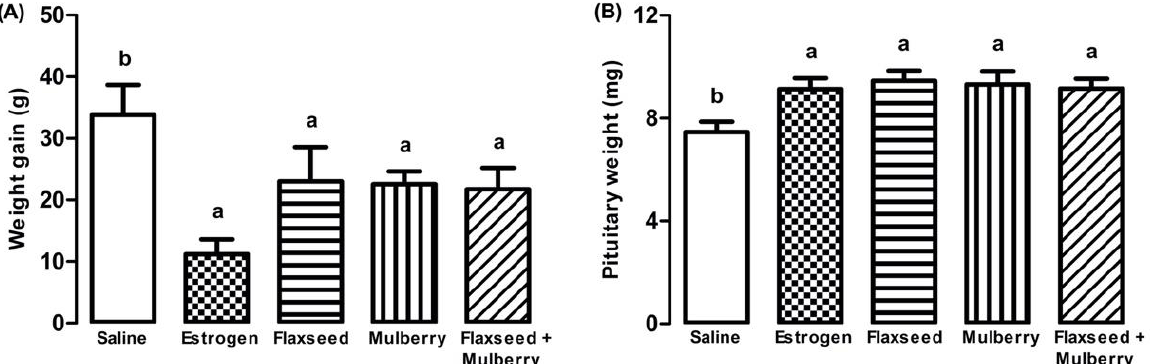
Figure 1. ( A ) Weight gain (grams) at 60 days and ( B ) pituitary weight (milligrams) of animals